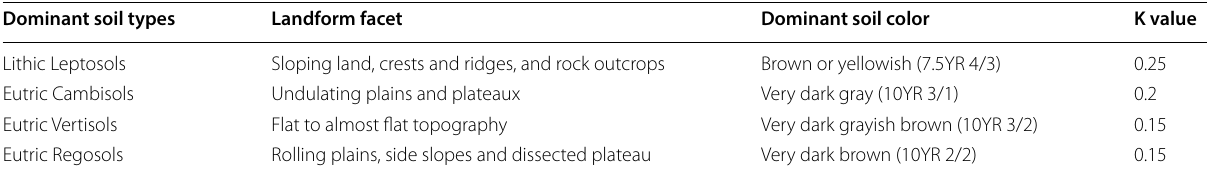
Table 3 Soil units, colors and their corresponding K factor value Source: Modified from Hurni (1985), Fenta et al. (2016), Gelagay and Minale